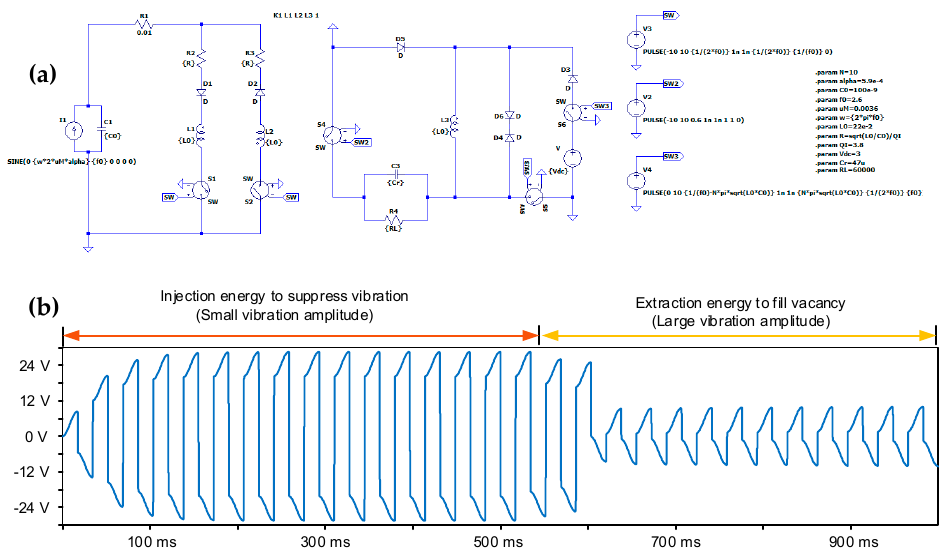
Figure 9. Simulation results of the ”suppress vibration and fill vacancy” function using an interface circuit: ( a ) the simulation circuit in LTspice; ( b ) the results of the ”suppress vibration and fill vacancy” function.